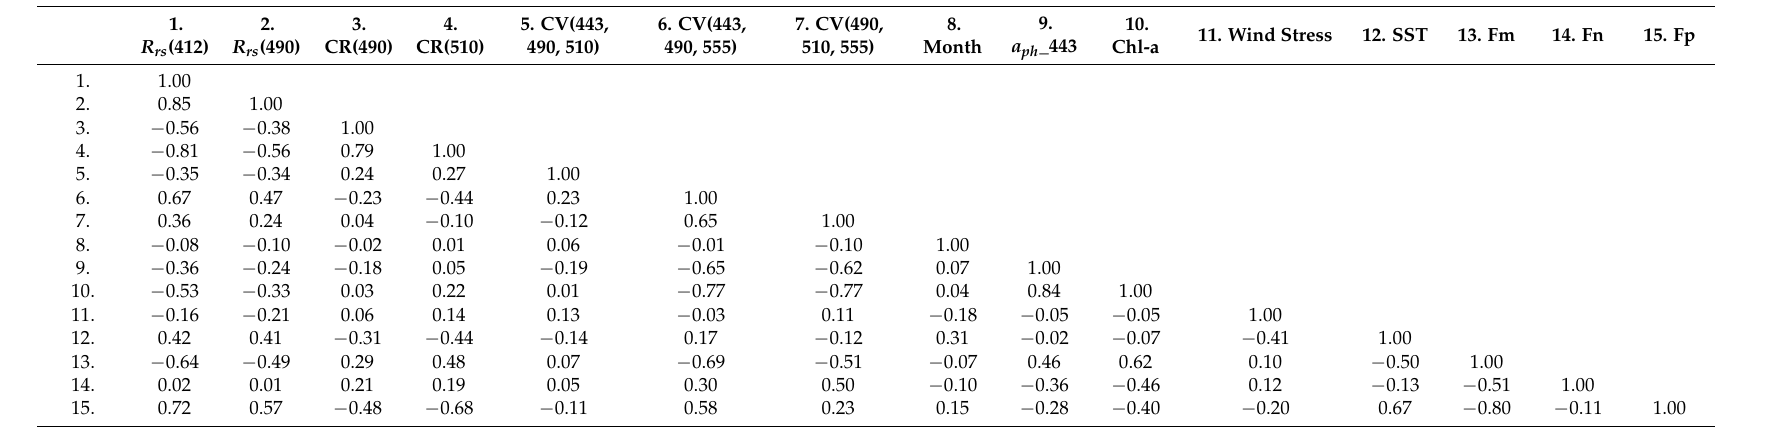
Table 8. Correlation matrix showing the relationships of some selected features against phytoplankton size